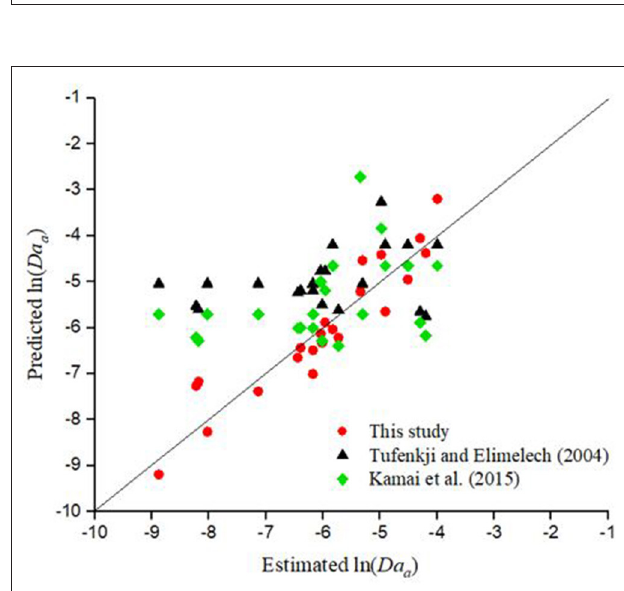
FIGURE 3 | Comparison of values of Da a predicted by the empirical equation developed in this study for bacteria (red circles, R 2 = 0.85) vs the corresponding estimated values reported in the literature ( Supplementary Table 2 ) obtained by fitting column experimental data with a 1D mathematical model. Also shown in the figure are the values of Da a predicted by CFT with η 0 calculated using the model of Tufenkji and Elimelech (2004; black triangles, R 2 = 0.103), and Kamai et al. (2015; green diamonds, R 2 =